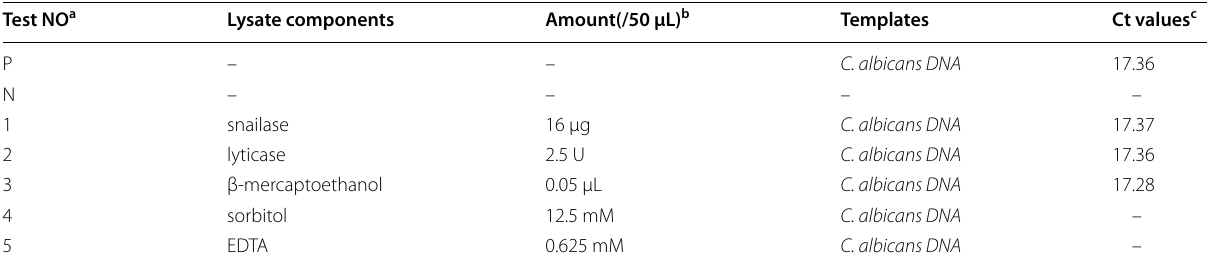
a P positive control, N negative control b The amounts were calculated according to the optimized lysis solution components c The Ct (crossing threshold) values describe the point where the amplification curve exceeds the noise